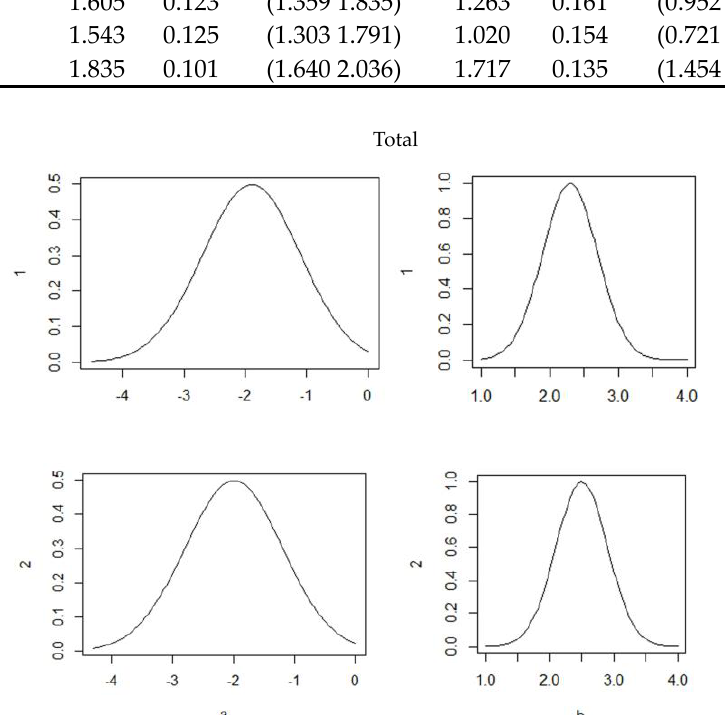
Figure 4. Posterior probability densities of two parameters for each total tree biomass model. 1 is the non-hierarchical approach, and 2 is the Bayesian hierarchical